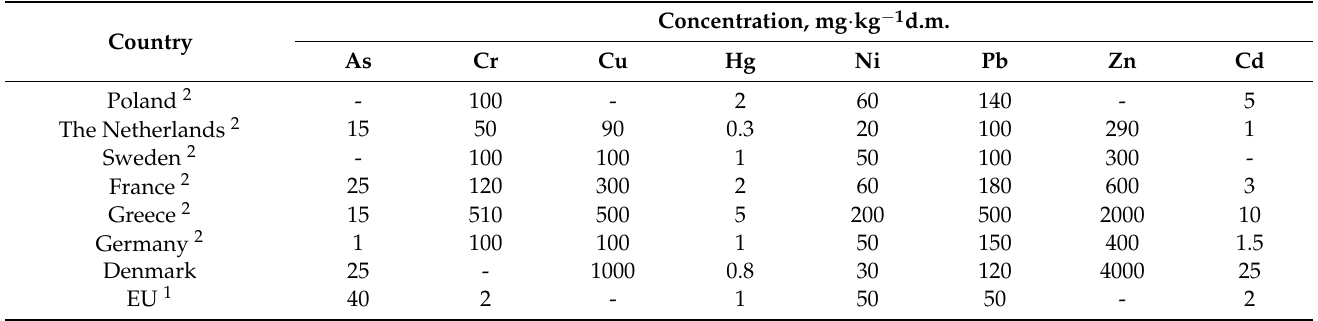
Table 1. Heavy metals limits in selected EU countries. Source: self-elaboration based on 1 Regulation (EU) 2019/1009 [11]; 2 Biala and Wilkinson